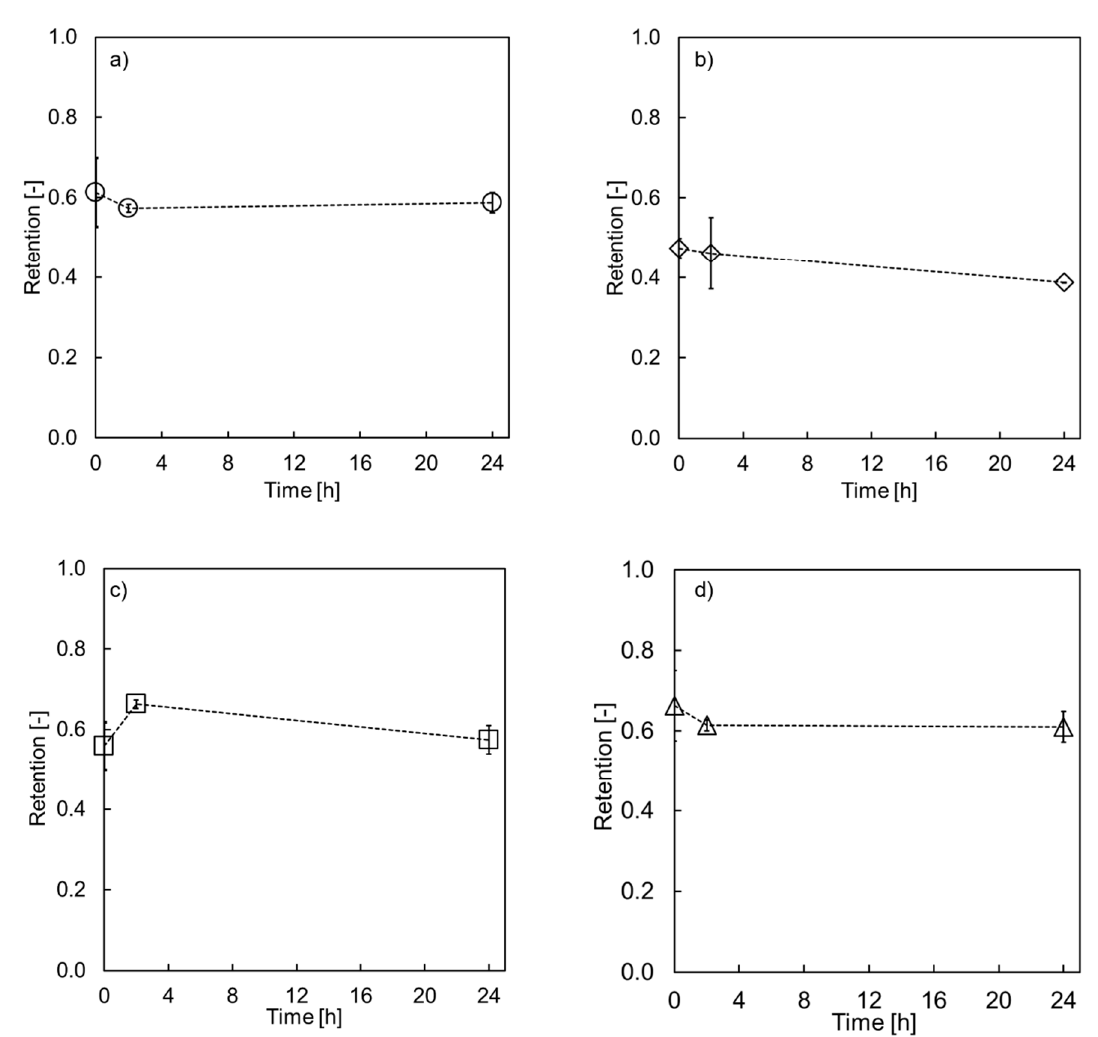
Figure 3. Mg retention values of membranes after filtering a 15% H 3 PO 4 solution at TMP = 5 bar, v = 2.65 m/s (Re > 2 ′ 300) for ( a ) PES (PDADMAC/PSS) 4 , ( b ) PES (PDADMAC/PSS) 8 , ( c ) sPES (PDADMAC/PSS) 4 , ( d ) sPES (PDADMAC/PSS) 8 as a function of H 3 PO 4 filtration time. ( d ) sPES (PDADMAC / PSS) 8 as a function of H 3 PO 4 filtration